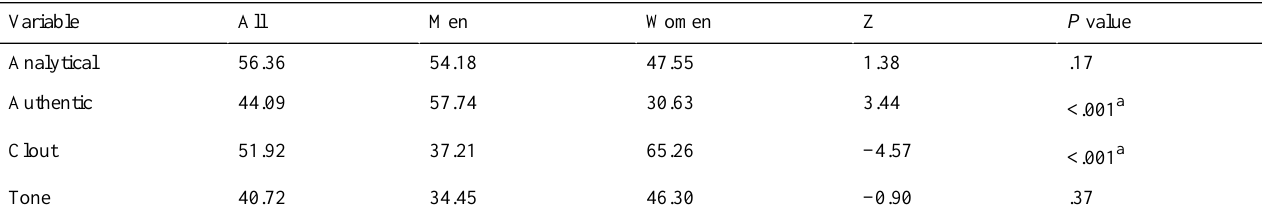
Table 1. Semantic analysis of the linguistic attributes of posts that are authored by men compared to those of their partners.